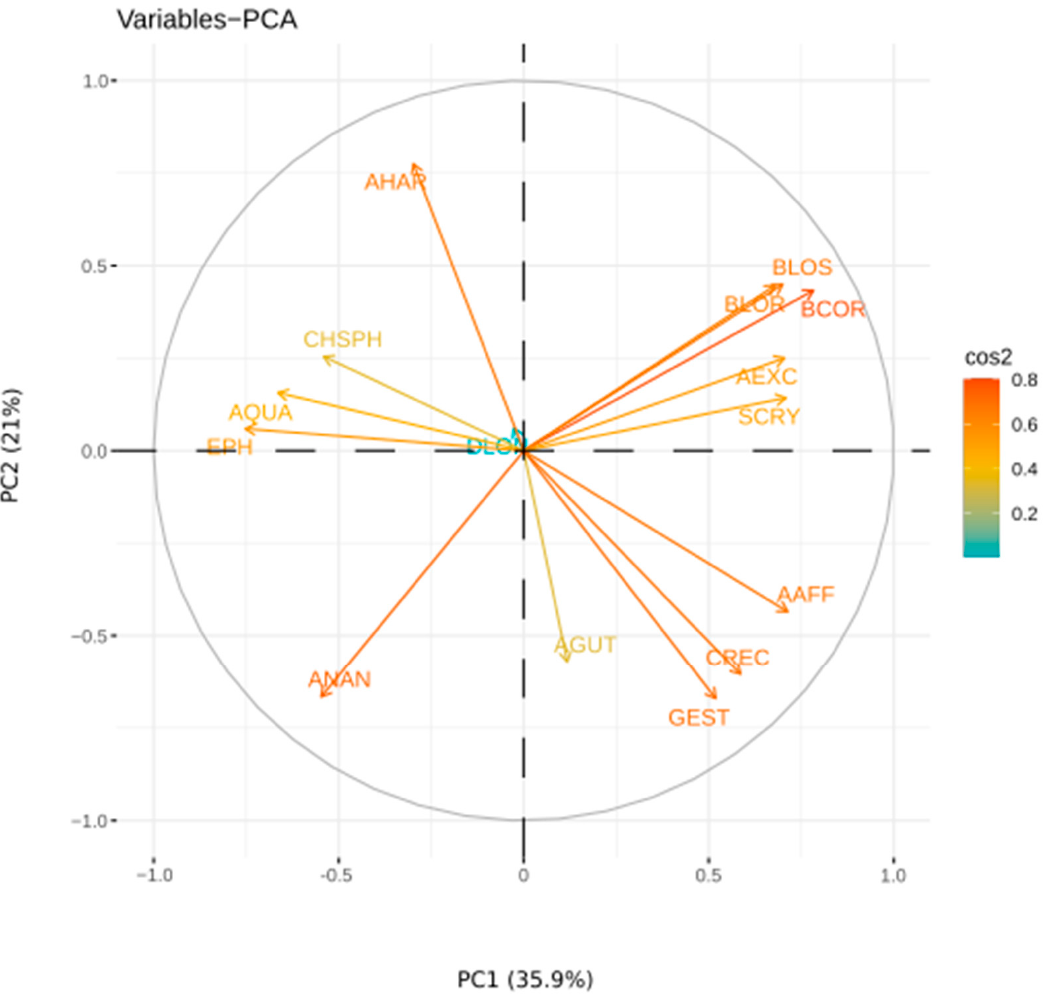
Figure 8. Principal Component Analysis (PCA; correlation matrix) Axes 1 and 2 of key cladoceran species. Variable (taxon) names: DLON = Daphnia longispina group; BCOR = Bosmina ( E. ) coregoni ; BLOR = Bosmina longirostris ; BLOS = Bosmina ( E. ) longispina ; AAFF = Alona affinis ; AHAR = Acroperus harpae ; AGUT = Alona guttata ; AQUA = Alona quadrangularis ; AEXC = Alonella excisa ; ANAN = Alonella nana ; CREC = Coronatella rectangula ; CHSPH = Chydorus sphaericus ; GEST = Graptoleberis testudinaria ; SCRL = Sida crystallina ; and EPH = ephippia.